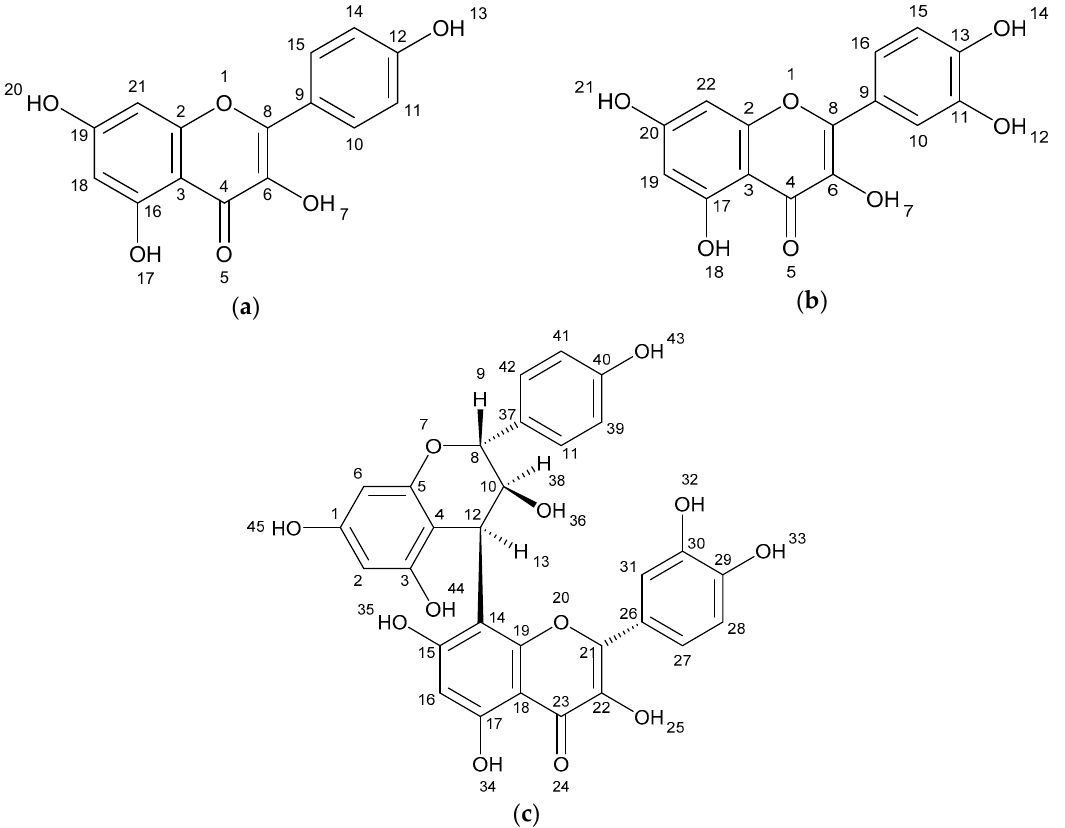
Figure 1. Structure of flavonoids and biflavonoid dimer with numbers associated to in silico results. ( a ) Kaempferol 287 g/mol ( b ) Quercetin 302 g/mol, and ( c ) Biflavonoid (afzelequin 4 β -8 quercetin), 574 g/mol.